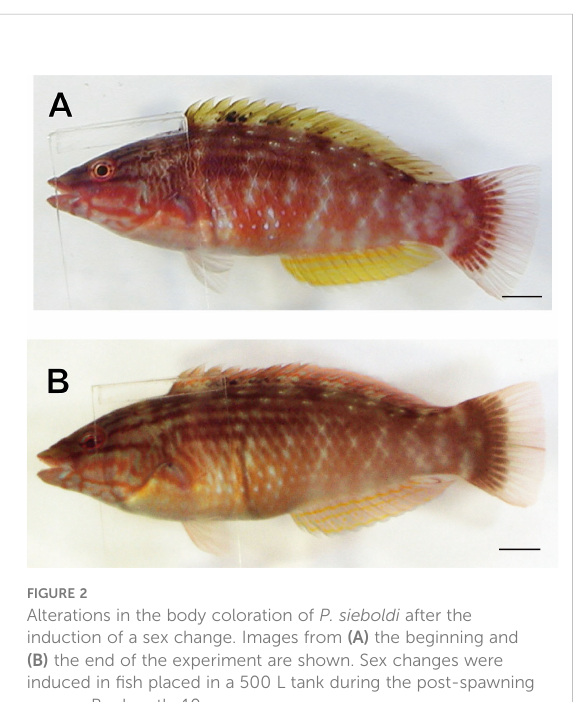
FIGURE 2 Alterations in the body coloration of P. sieboldi after the induction of a sex change. Images from (A) the beginning and (B) the end of the experiment are shown. Sex changes were induced in fi sh placed in a 500 L tank during the post-spawning season. Bar length, 10 mm.